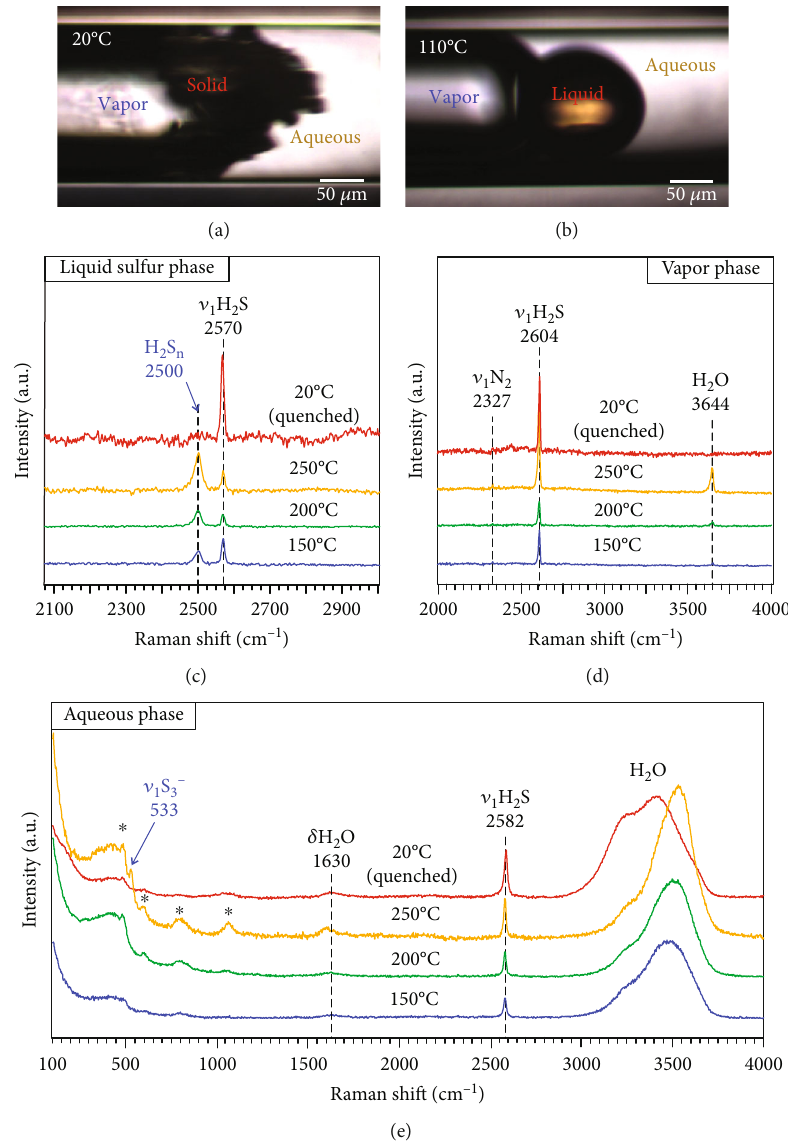
Figure 5: Phase behaviors and in situ Raman spectra of the S – H phases at 20 ° C; (b) coexisting liquid S, vapor, and aqueous phases at 110 ° C; Raman spectra of liquid (c), vapor (d), and aqueous (e) phases at 150 – 250 ° C. Raman spectra of the quenched sample (20 ° C) are also shown for comparison. Stars denote the background signals of the silica